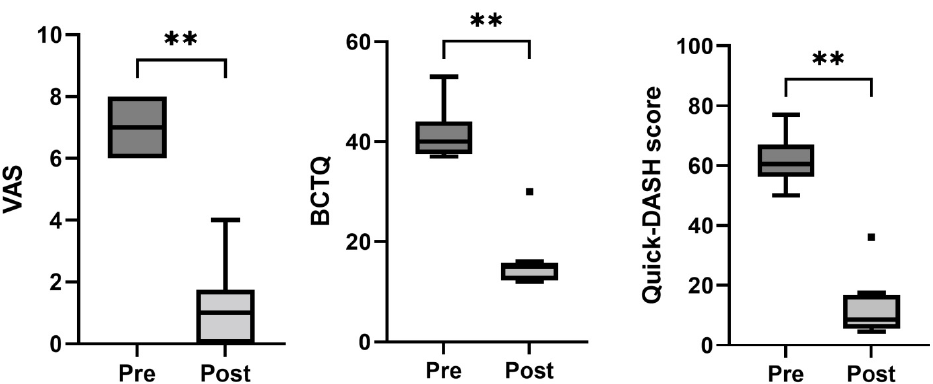
Figure 3. Box-and-whisker plots showing the results of the recurrent carpal tunnel syndrome group for visual analogue scale (VAS), Boston Carpal Tunnel Questionnaire (BCTQ), and Quick-DASH score. The boxes show the median and interquartile range (IQR), and the whiskers indicate the 25th percentile − 1.5 × the IQR and the 75th percentile − 1.5 × IQR. The square points indicate outliers outside the whisker range. ** indicates p < 0.01 ( n = 8).